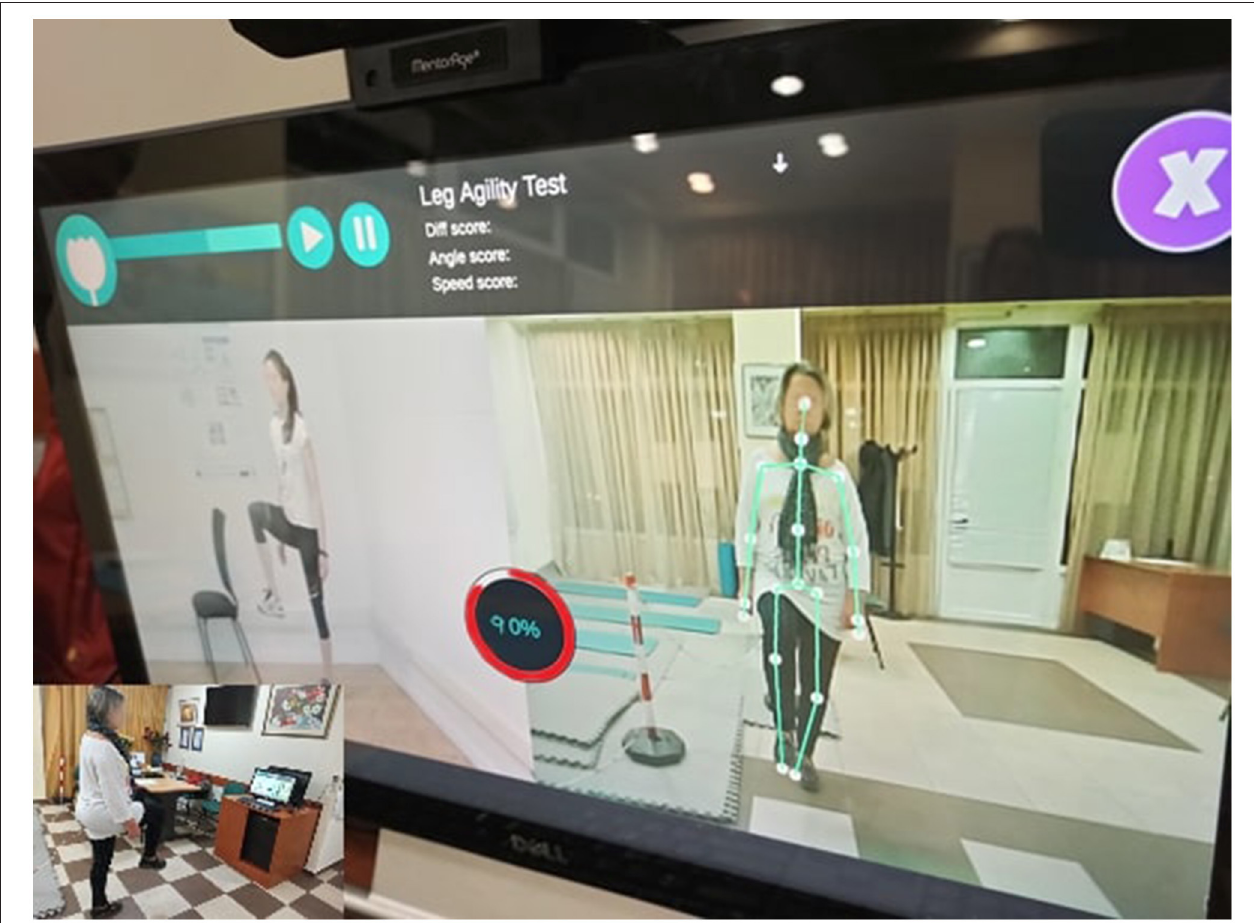
FIGURE 3 | The i-PROGNOSIS iMAT assessment environment during its use by a patient with PD (right panel), trying to imitate the expert’s leg posture (left panel), achieving high accuracy of